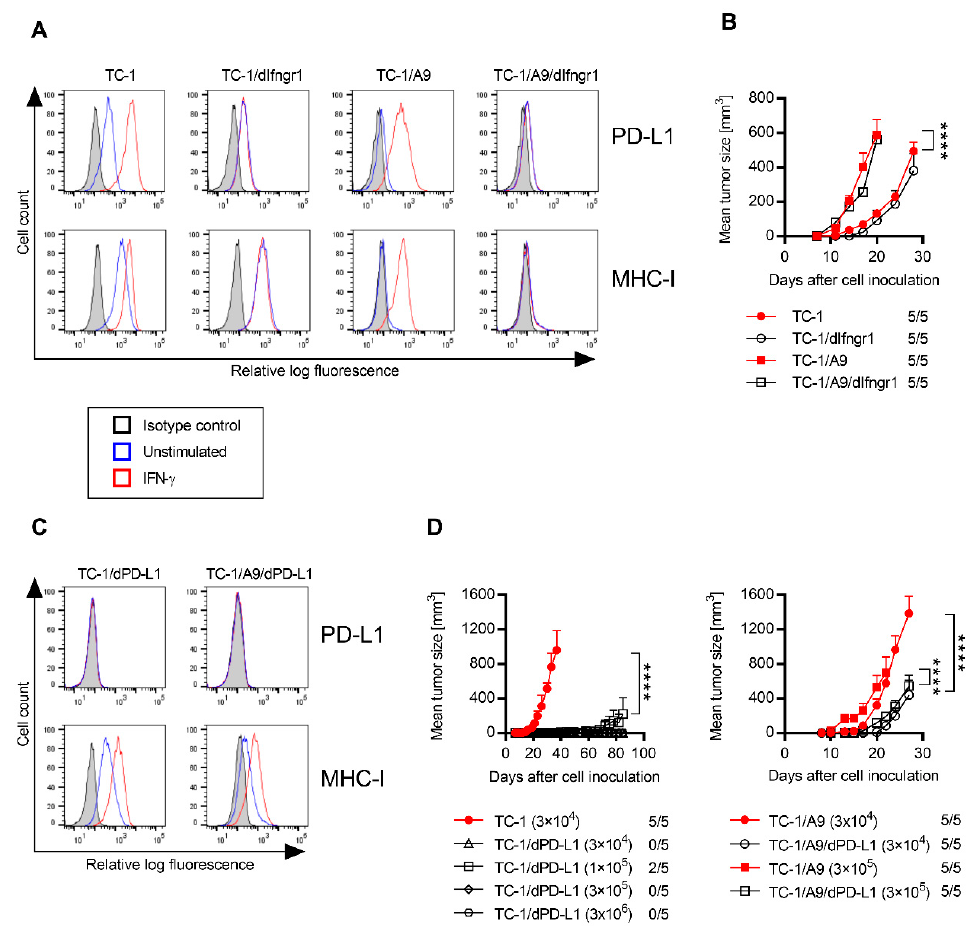
Figure 1. Characterization of the derived cell lines. Surface programmed cell death protein 1 (PD-1) ligand 1 (PD-L1) and major histocompatibility complex class I (MHC-I) expression on unstimulated and stimulated (200 IU/ml interferon (IFN)- γ for 1 day) cells were analyzed by flow cytometry in TC-1, TC-1 clone with a deactivated IFN- γ receptor 1 (IFNGR1; TC-1/dIfngr1), TC-1/A9, and TC- 1/A9/dIfngr1 cell lines ( A ) and TC-1/dPD-L1 and TC-1/A9/dPD-L1 cell lines ( C ). Cells were incubated with specific antibodies or isotype control antibodies. ( B ) Oncogenicity of TC-1, TC-1/dIfngr1, TC-